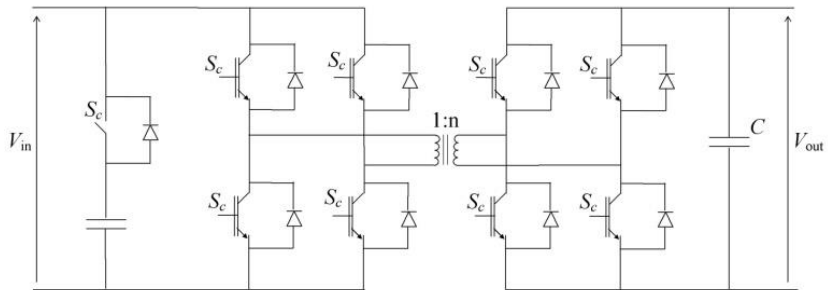
Figure 2. Full-bridge bidirectional converter.